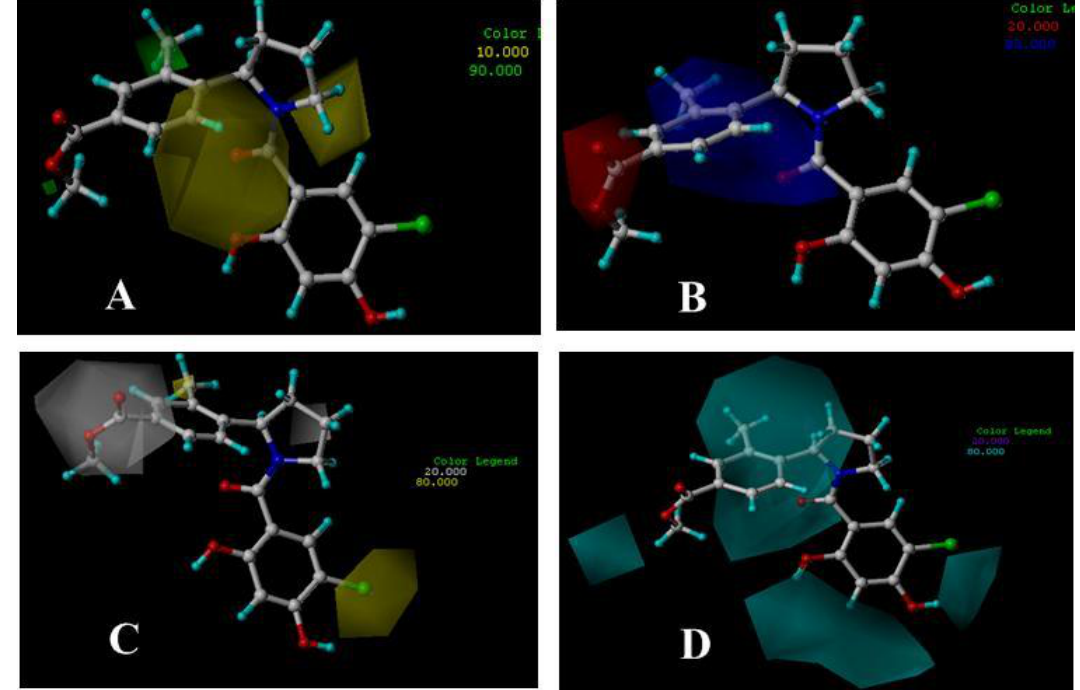
Figure 8. CoMSIA StDev*Coeff contour plots for Dihydroxylphenyl amides in combination with compound 19. ( A ) The green (sterically favorable) and yellow (sterically unfavorable) contours represent 90% and 10% level contributions, respectively; ( B ) The blue (electropositive charge favorable) and red (electronegative charge favorable) contours represent 80% and 20% level contributions, respectively; ( C ) The yellow (hydrophobic favorable) and white (hydrophobic unfavorable) contours represent 80% and 20% level contributions, respectively; ( D ) The cyan (hydrogen-bond-donor favorable) and purple (hydrogen-bond-donor unfavorable) contours represent 80% and 20% level contributions,